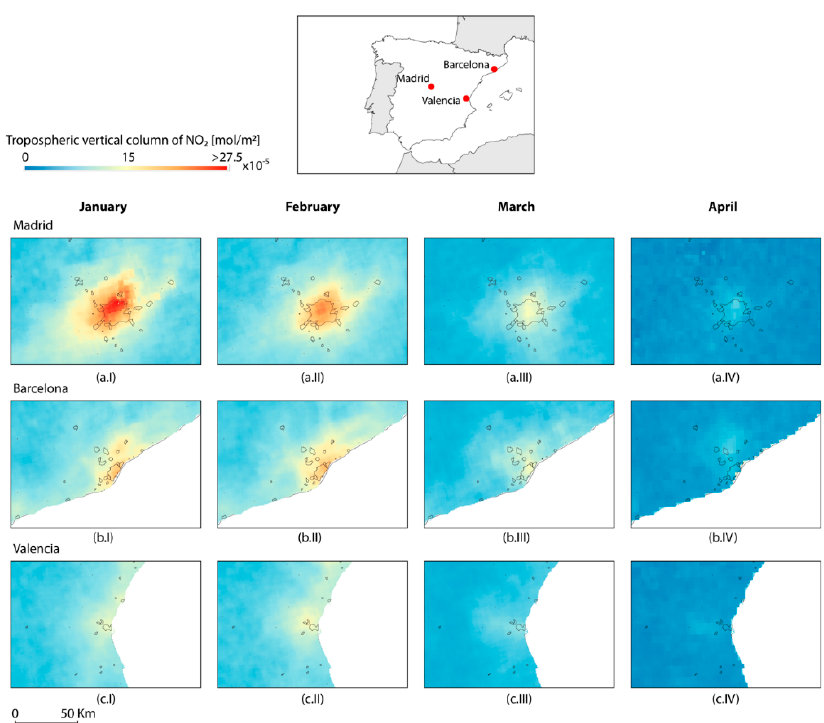
Figure 6. Monthly maps of average values of Tropospheric vertical column of NO 2 in ( a ) Madrid, ( b ) Barcelona and ( c ) Valencia for 2020 during the months of ( I ) January, ( II ) February, ( III ) March and ( IV ) April.